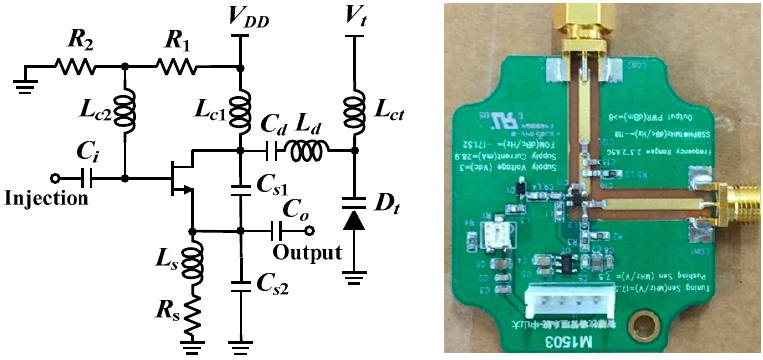
Figure 3. Schematic and photograph of the S-band SILO.